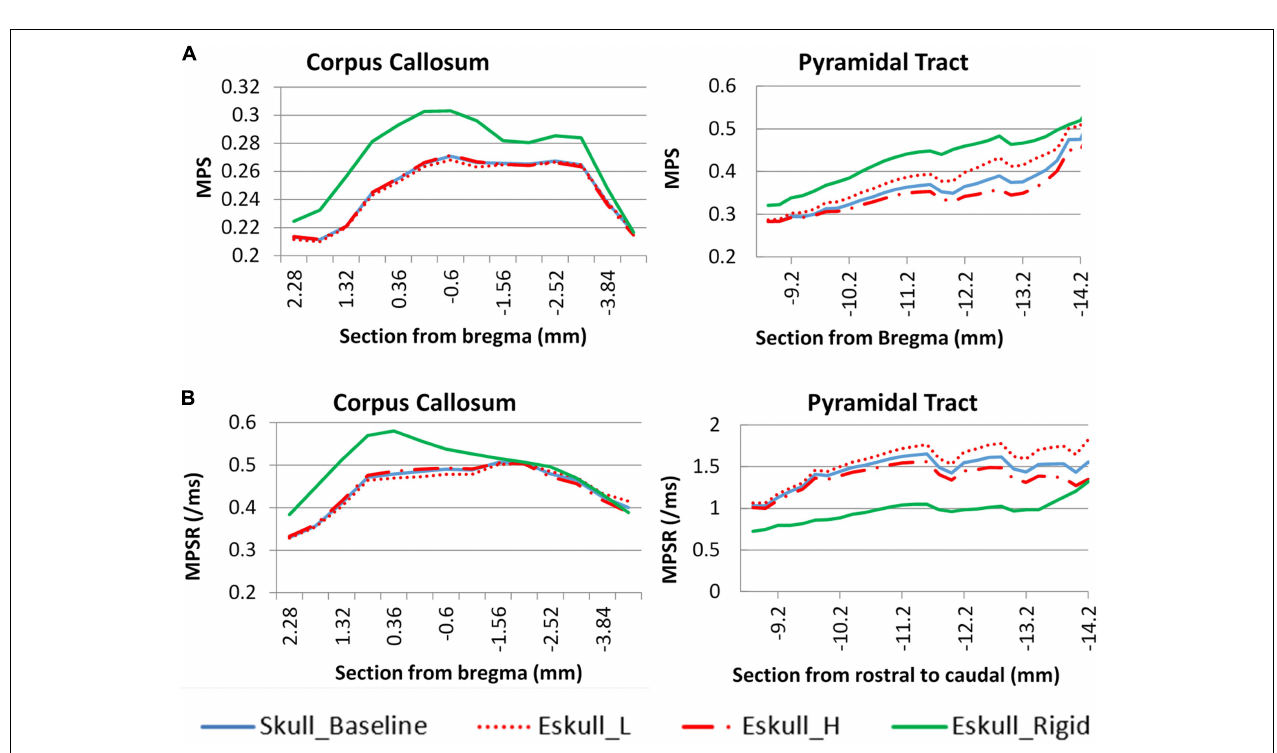
FIGURE 9 | Skull stiffness effect comparison for two white matter structures. (A) : maximum principle strain; (B) : maximum principle strain rate.